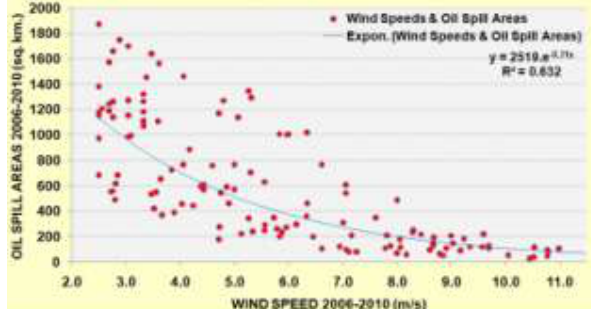
Figure 10. Exponential Regression Analysis between Wind Speeds from OSCAR Software & Detected Oil Slick Areas